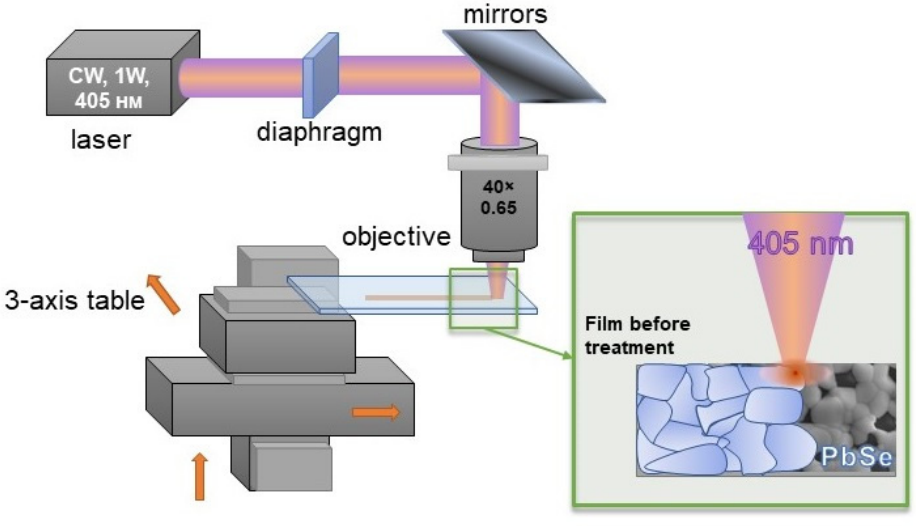
Figure 1. Experimental setup scheme for chalcogenide film’s structure laser modification. The radiation incident power on the film in the laser exposure mode was 22–33.6 kW/cm 2 with a spot diameter of about 10 µ m. The radiation intensity profile in the spot cross-section was a beam with a flat top. The film structure was modified at a laser spot scanning rate of 950 µ m/s.